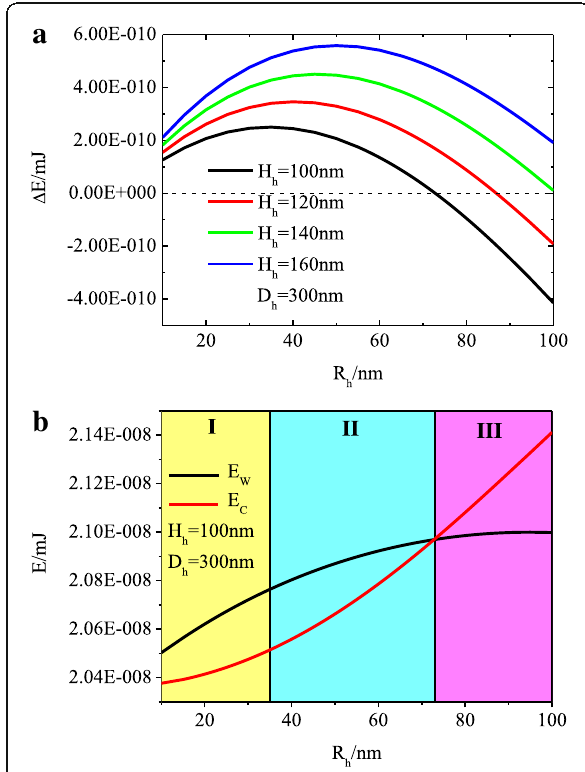
Fig. 3 a The free energy difference between the W and CB states of a water droplet on nanohole-patterned surfaces when the nanohole depth and spacing have uniform values and varying feature sizes R h . b The individual free energy profiles of the W state and the CB state for the black line in ( a